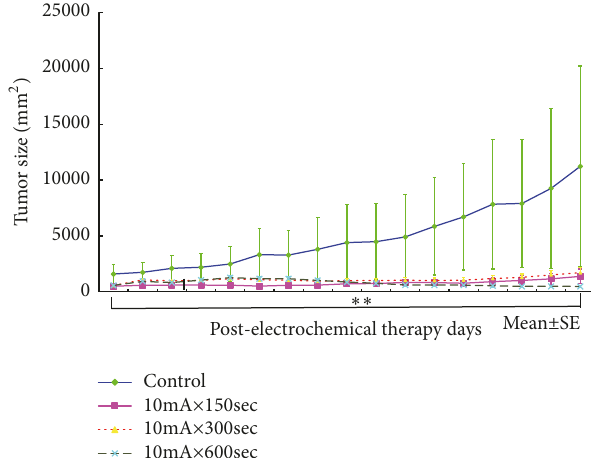
Figure 7: Changes of the tumor volume after Ehrlich carcinoma inoculation in the groups of control, 10mA × 150sec, 10mA × 300sec, and 10mA × 600sec ( ∗∗ p < 0.01 ). The results represent ± S.D. from 8 to 10